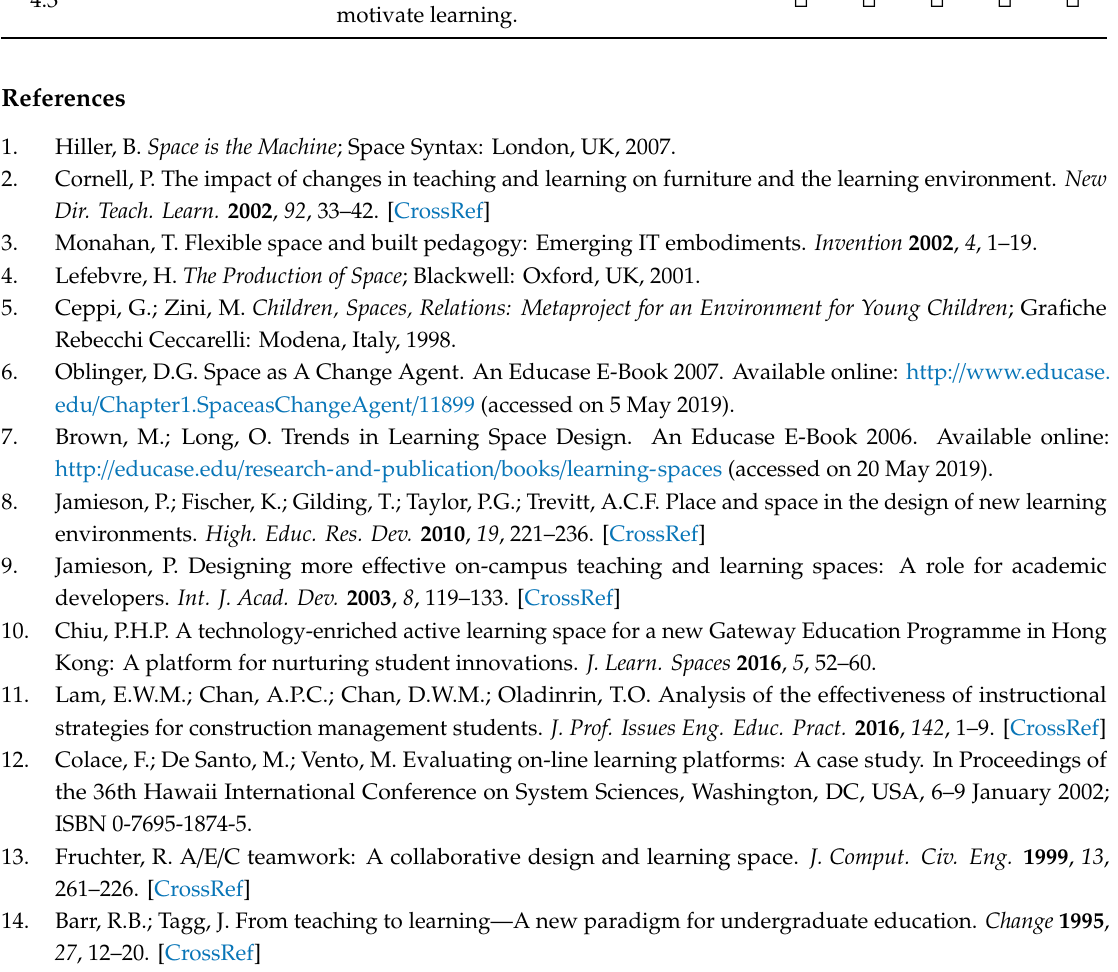
Flexibility of Space Design The learning space is designed for various usage (e.g., massive 2.1 lecture vs. small group discussion for seminar). 2.2 The space design facilitates group discussion. The furniture can be easily reconfigured to facilitate grouping in 2.3 di ff erent sizes. Comfort Moveable chairs equipped with flexible back and adjustable seat 3.1 height can improve learning comfort. 3.2 The acoustic room design is satisfactory. 3.3 Lighting is ambient. 3.4 Adjustable lighting level can enhance learning comfort. 3.5 The interior temperature is comfortable. 3.6 Adjustable interior temperature can enhance learning comfort. Esthetic 4.1 The interior learning environment is enjoyable. 4.2 Vibrant colors can motivate learning. The textures, patterns, and finishing are appealing, which can 4.3 motivate